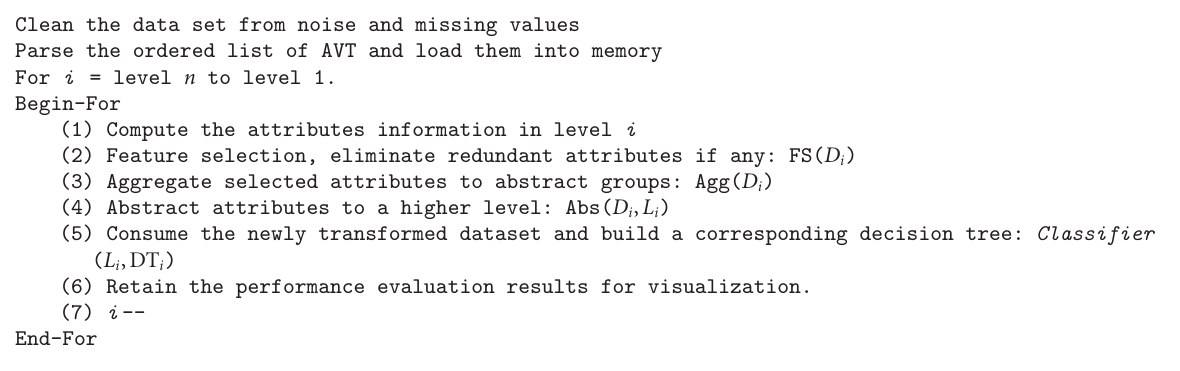
Algorithm 1: Operation of the